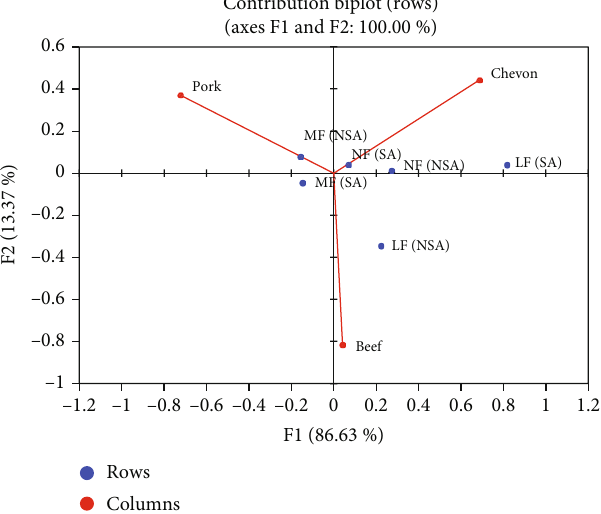
Figure 1: Percentage of participants who identi fi ed the chevon, beef, or pork sausage as being the most distinct of the three sausages (a). Contribution biplot representing the average liking of each sausage